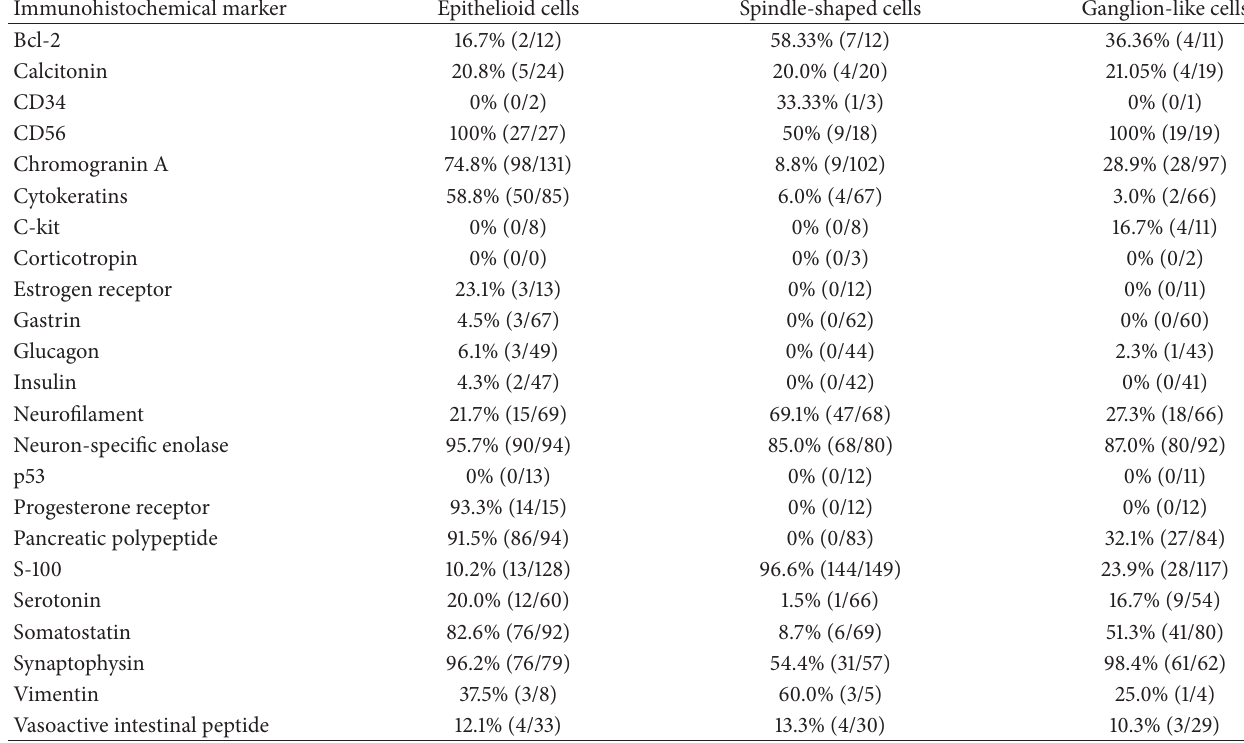
Table 1: Immunohistochemical findings in each tumor component of gangliocytic paraganglioma.